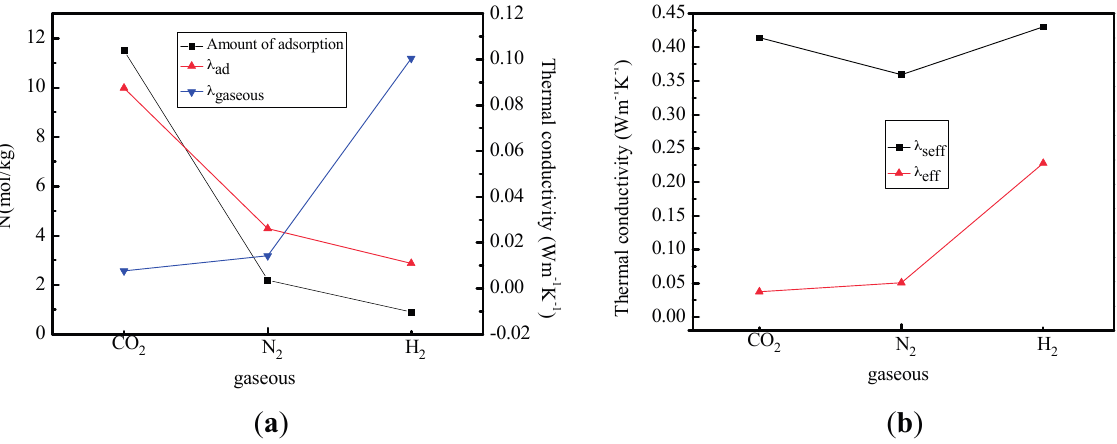
Figure 10. Varying porosity and thermal conductivity at different solid thermal conductivity values.